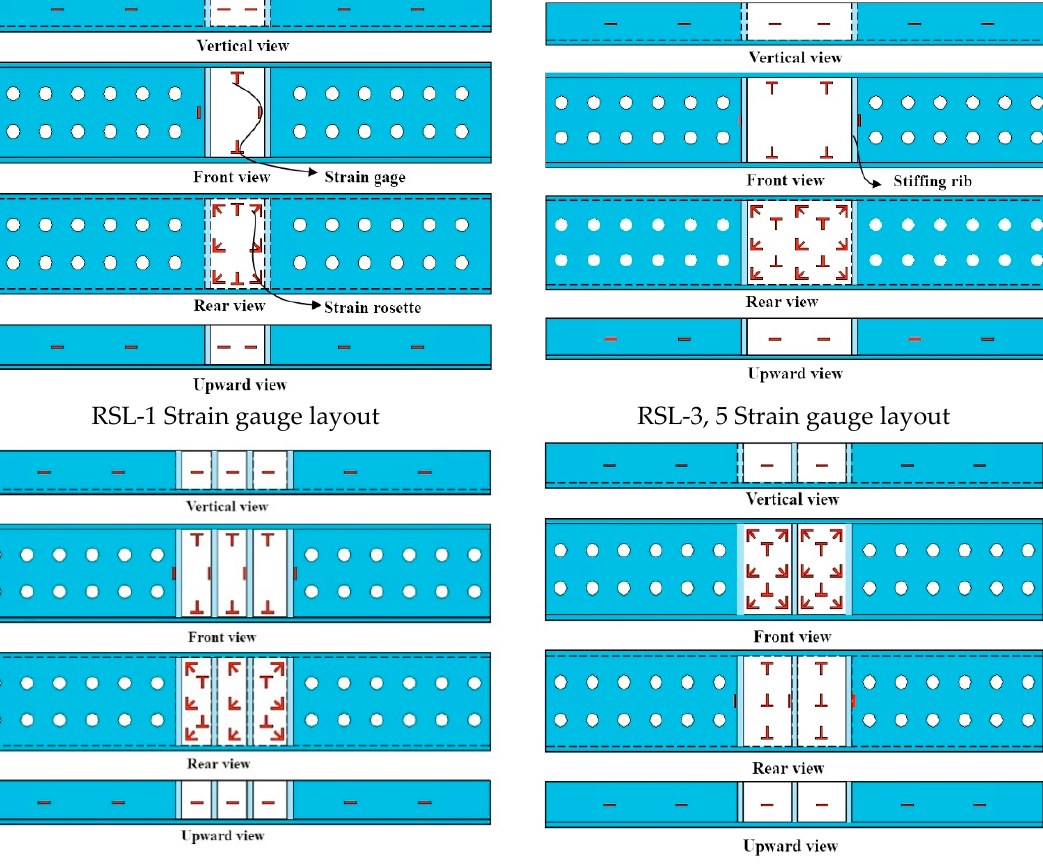
Figure 4. The measurement arrangement of strain gauge and strain rosette.